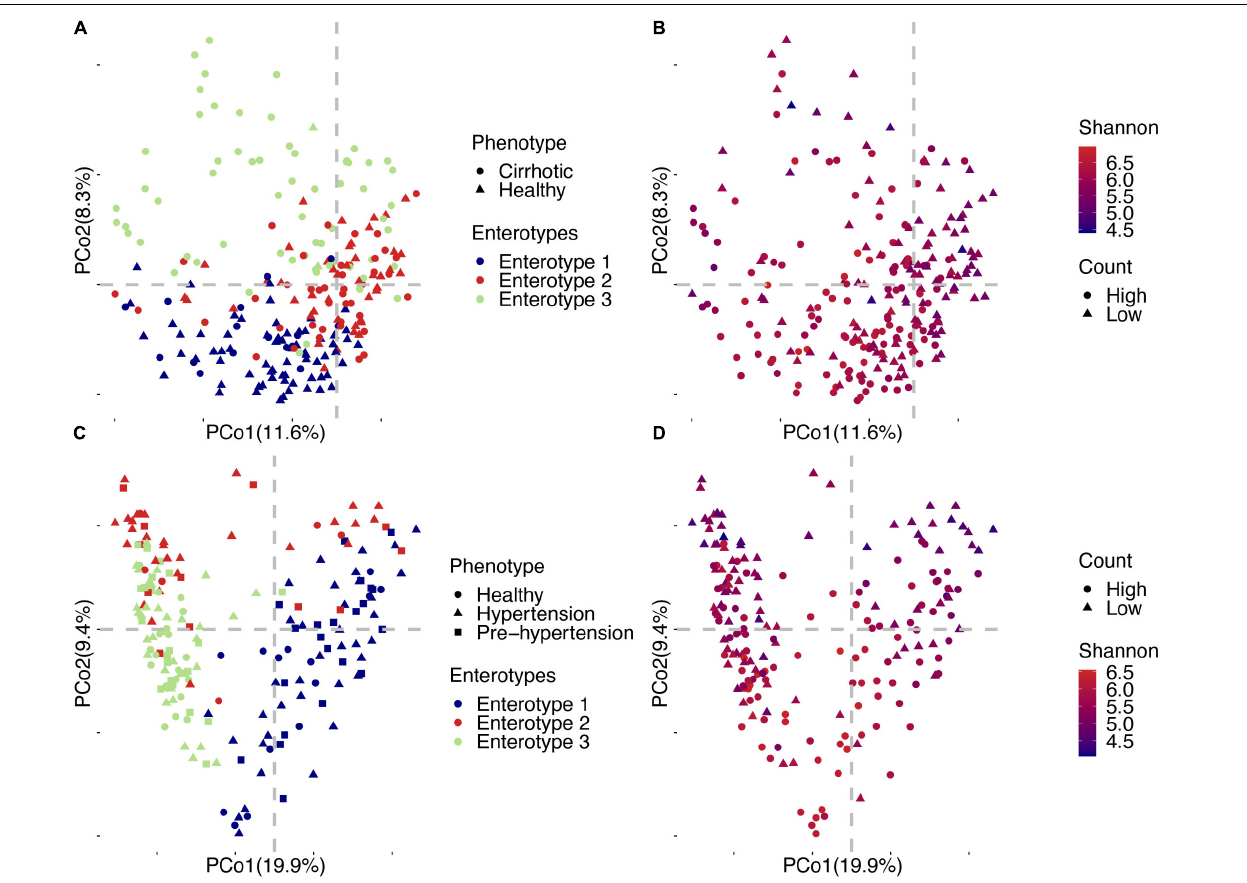
FIGURE 6 | Detailed PCoA map of liver cirrhosis and hypertension. (A) Samples of liver cirrhosis were plotted in relation to their phenotype and enterotypes. (B) Samples of liver cirrhosis were plotted in relation to their viral count and Shannon index. (C) Samples of hypertension were plotted in relation to their phenotype and enterotype. (D) Samples of hypertension were plotted in relation to their viral count and Shannon index.